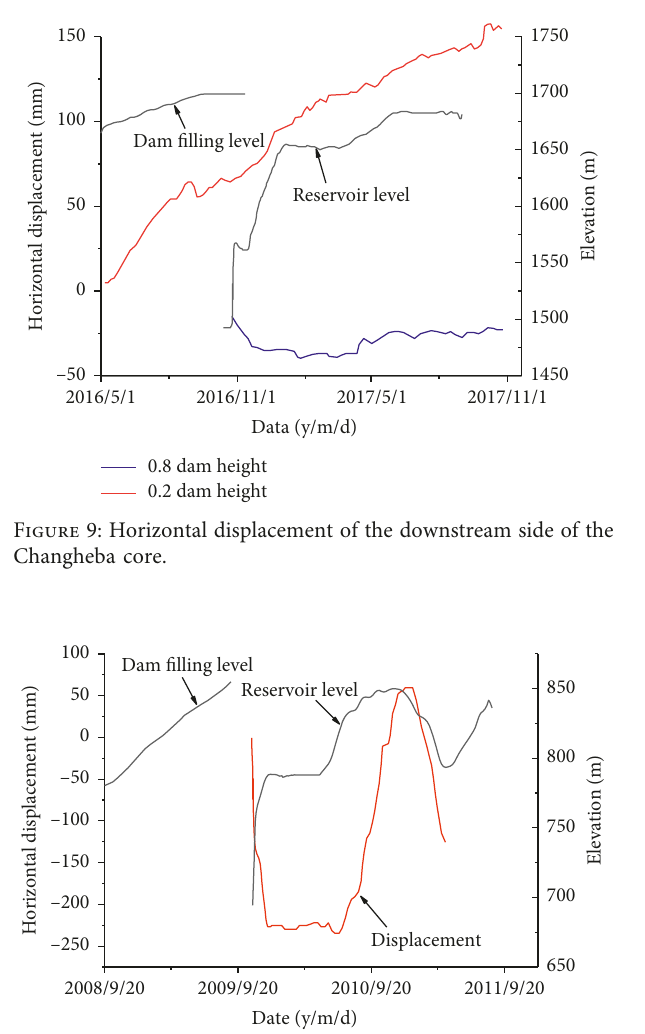
Figure 10: Horizontal displacement of the downstream filter zone at the dam crest of the Pubugou dam. Table 7: The dam construction and the initial impounding period. Dam construction Dam